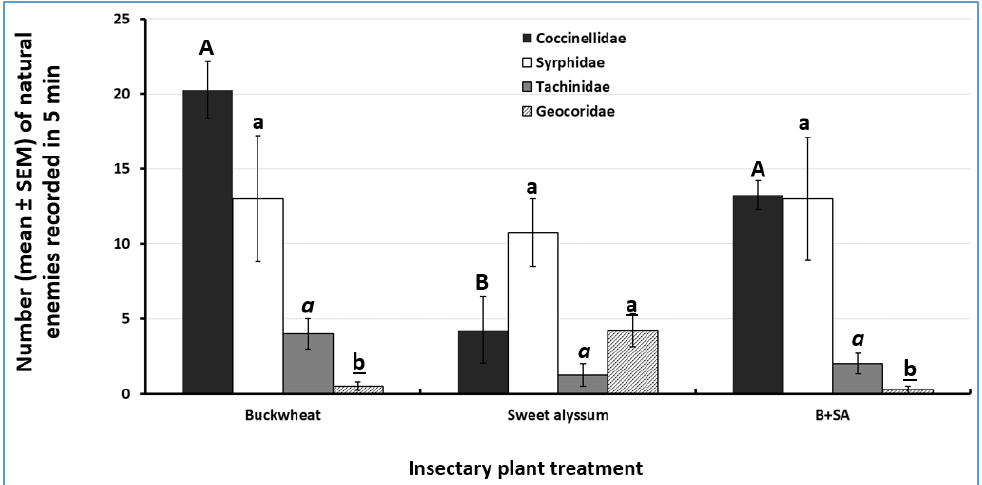
Figure 5. Insectary plant natural enemy abundance, on a per-plant basis. B+SA = Buckwheat and sweet sweet alyssum mixture. For each insect family, bars with di ff erent letters are significantly di ff erent alyssum mixture. For each insect family, bars with different letters are significantly different according to ANOVA and Fisher-protected LSD tests ( p < 0.05). according to ANOVA and Fisher-protected LSD tests ( p <